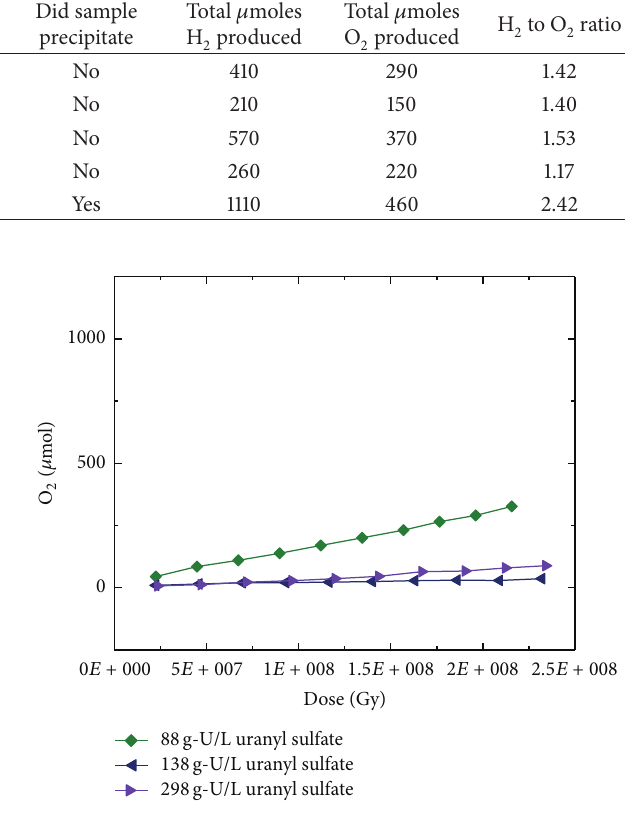
Figure 6: Oxygen evolution measured during irradiation of UO 2 SO 4 solutions at the Van de